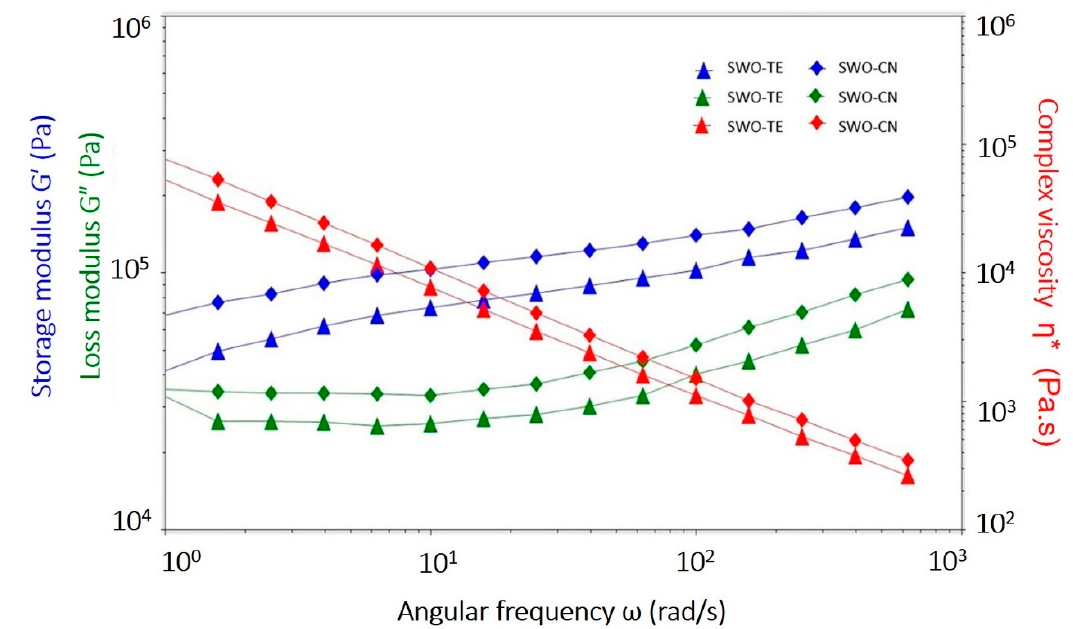
Figure 2. The frequency sweep test graphics of the oleogel samples (SWO-TE: sunflower wax oleogel with thyme, SWO-CN: sunflower wax oleogel with cumin).